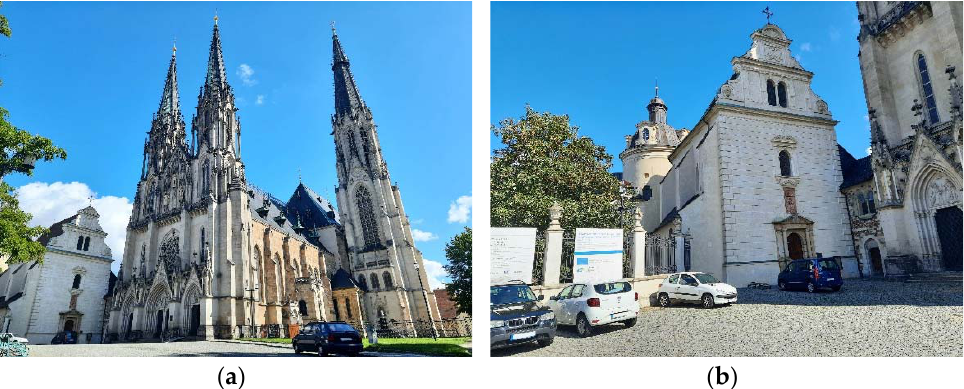
Figure 1. The current appearance (as of the year 2022) of Saint Wenceslas Cathedral ( a ) and Chapel of St. Anne ( b ) (source: authors). St. Anne ( b ) (source: